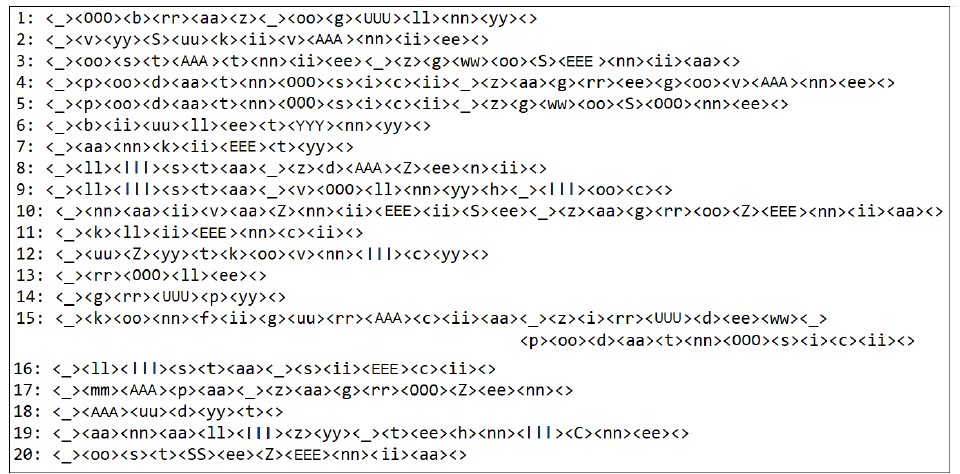
Figure 22. Illustration of time-relevant phonetic modelling of 20 commands.